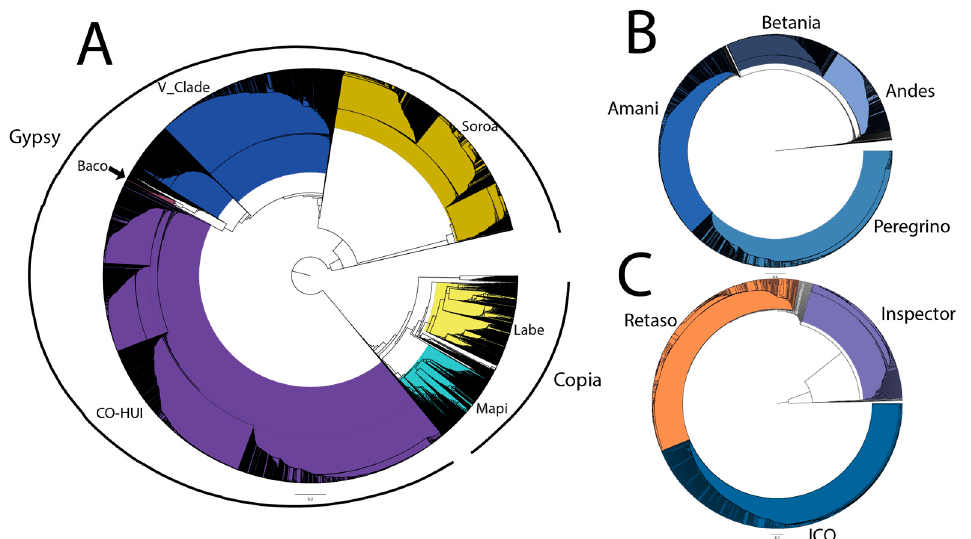
Figure 1. Phylogenetic trees of the 6476 identified RT domains (>200 amino acids) present in the Hv33 assembly. ( A ) the super families and their lineages. ( B ) The sub-families belonging to the CO-HUI lineage. ( C ) The sub-families that are present in the Soroa family.